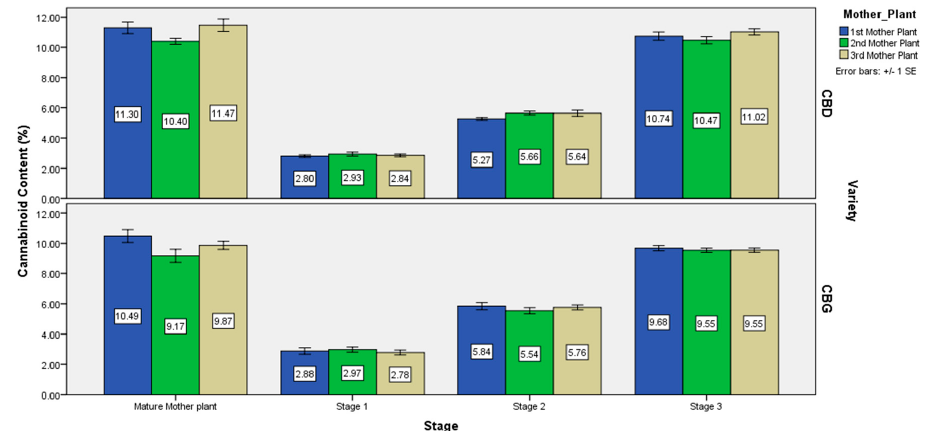
Figure 3. The CBD + CBDA and CBG + CBGA content (%) of the field grown mother plants and their Figure 3. The CBD+CBDA and CBG+CBGA content (%) of the field grown mother plants and their clones at three different growth stages of the two high CBD and CBG Cannabis sativa varieties. clones at three di ff erent growth stages of the two high CBD and CBG Cannabis sativa